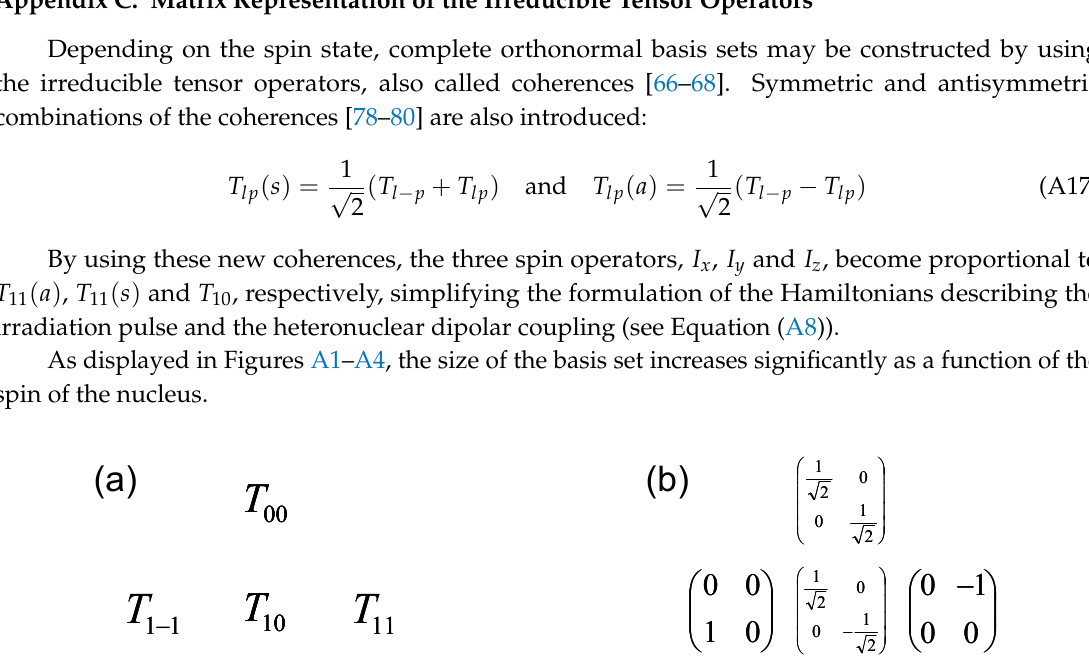
Figure A1. Complete orthogonal basis set (four elements) describing the evolution of the spin I = 1/2 (Pauli matrices): ( a ) symbolic representation T ij ; ( b ) explicit matrix representation of irreducible tensor